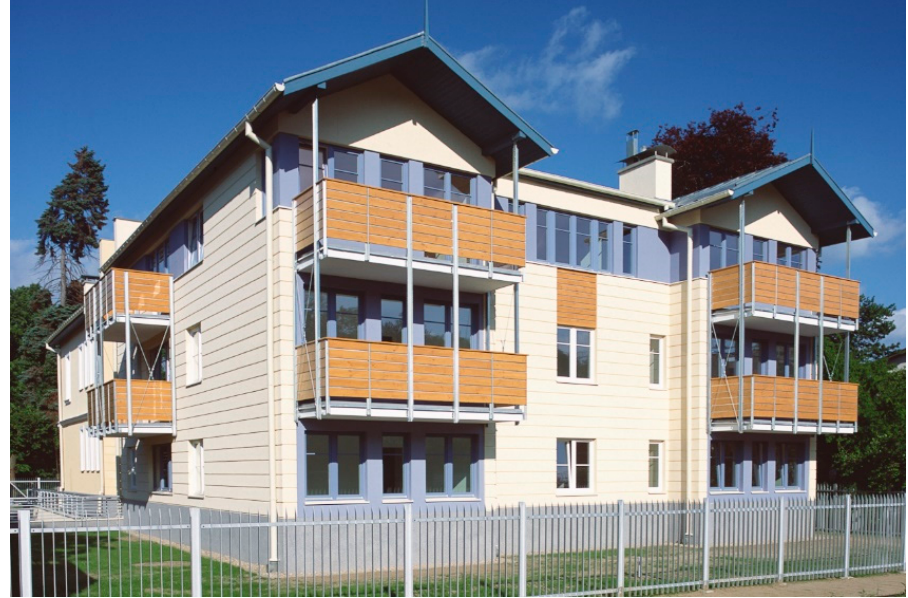
Figure 14. Extended part of Willa Halina. Source: FORT Taraszkiewicz Architekci.